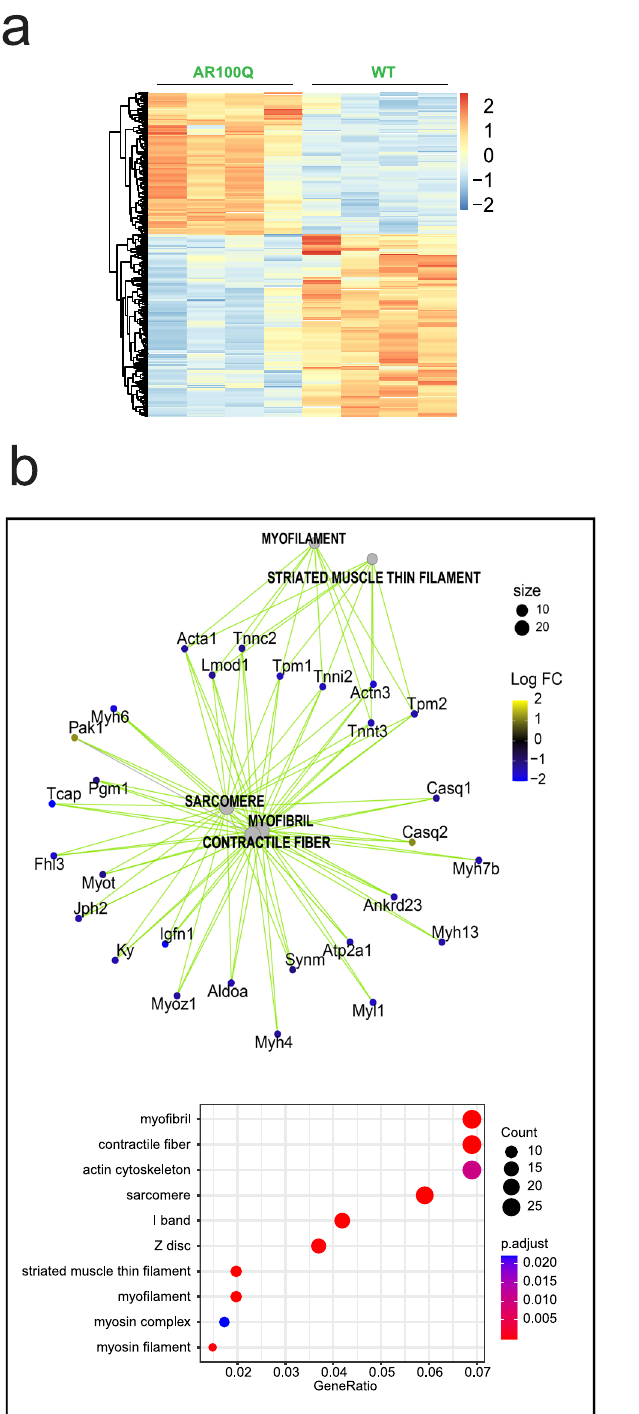
Fig. 2 | Progressively altered expression of genes involved in sarcomere orga- nization and muscle contraction in SBMA transgenic mice. a Transcriptomic (RNA-seq) analysis in the quadriceps muscle of 4-week-old (green) and 8-week-old